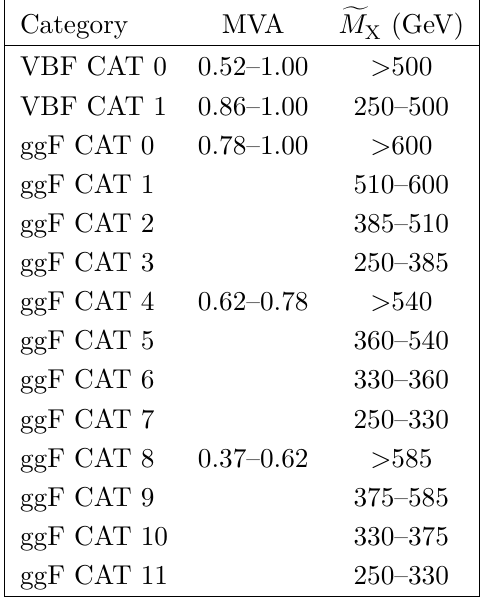
Table 2 . Summary of the analysis categories. Two VBF- and twelve ggF-enriched categories are defined based on the output of the MVA classifiers and the mass of the Higgs boson pair system f M X . The VBF and ggF categories are mutually